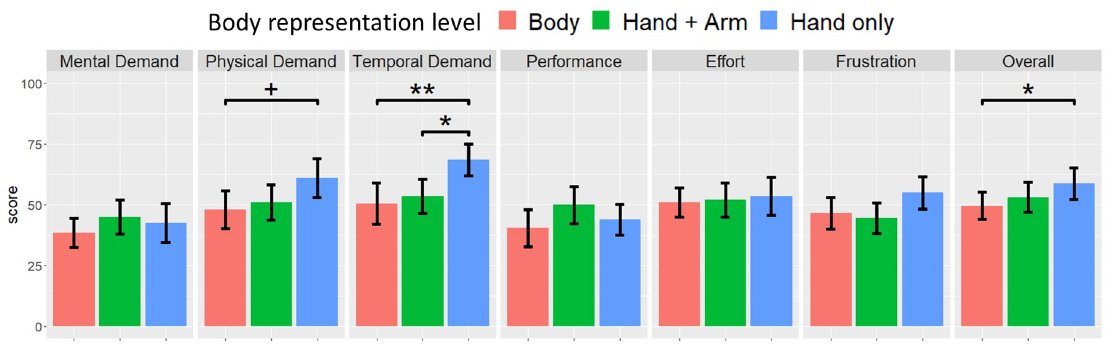
Figure 5. Score of NASA-TLX sub-scales (+ p < 0.1, * p < 0.05, ** p < 0.01). All error bars represent standard errors.